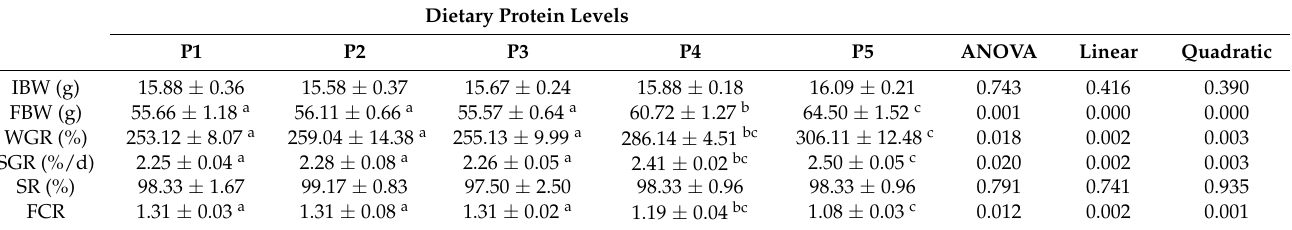
Table 3. Effects of dietary protein levels on growth performance of Oncorhynchus mykiss . Dietary Protein Levels